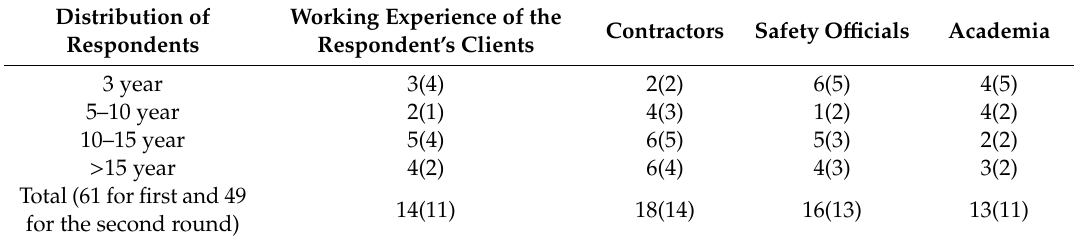
Table 2. Group Wise distribution of the respondents for two rounds of Delphi